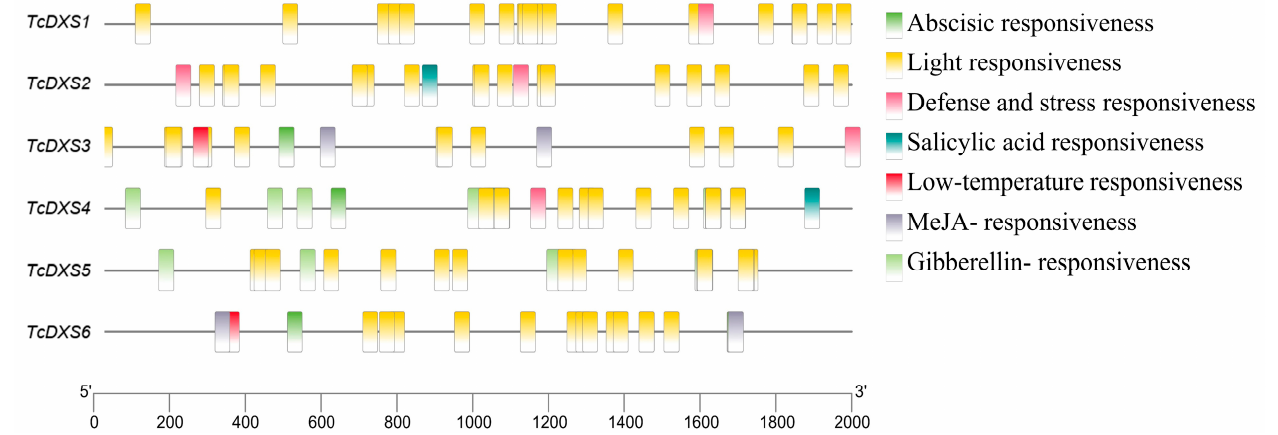
Figure 5. Analysis of the TcDXS promoters’ cis-acting elements, with seven response types; each containing several elements.